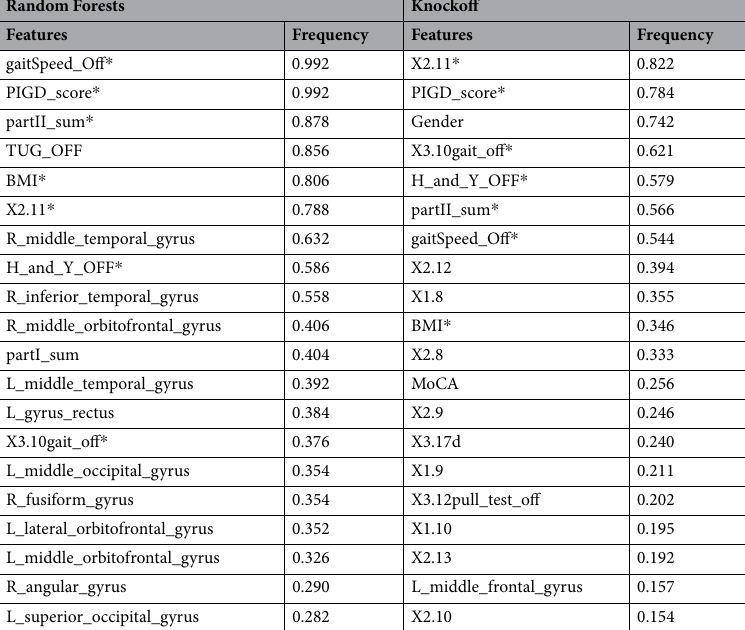
Random Forests Knockoff Features